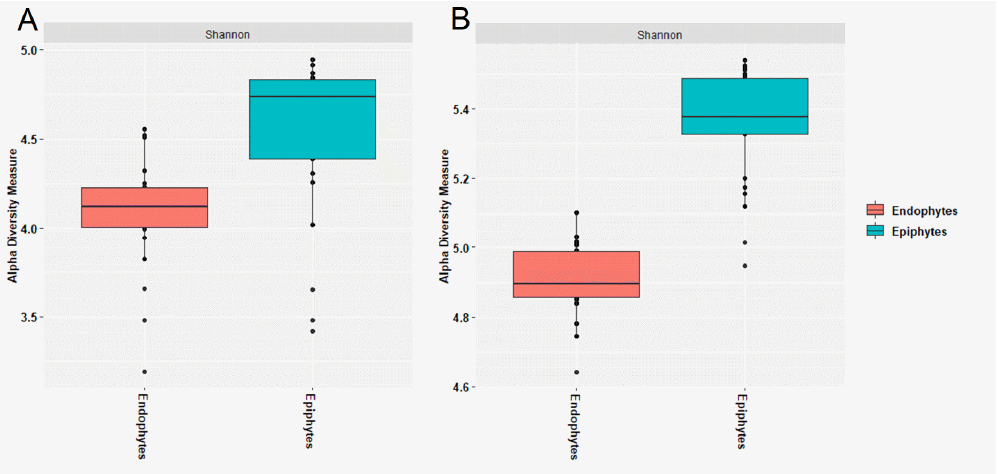
Figure 3. Alpha diversity analysis (based on Shannon diversity index) of the bacterial ( A ) and fungal ( B ) epiphytes and endophytes in stored wheat grain samples. The centered square represents the mean, black line inside the box represents the median, and circles indicate outliers.